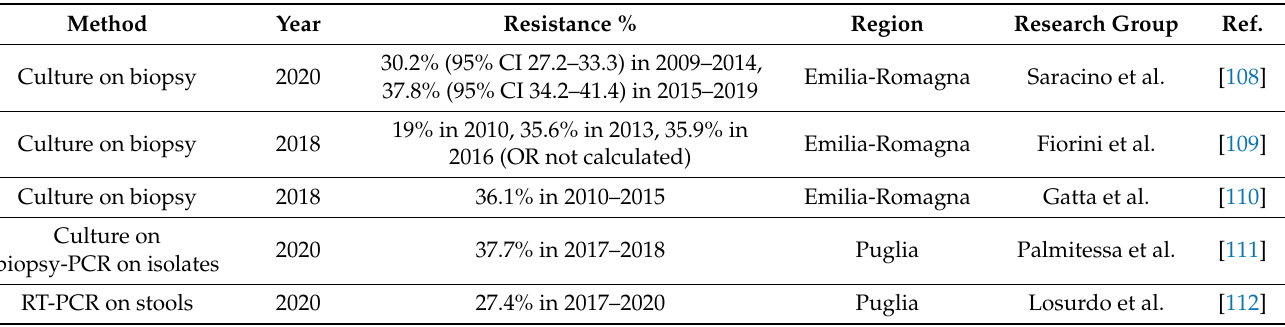
Table 1. Primary clarithromycin resistance in Italy.